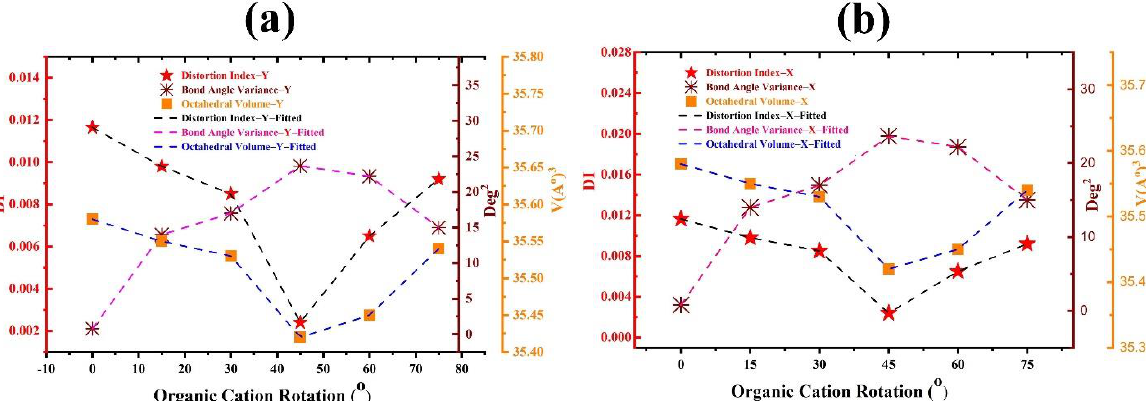
Figure 5. Calculated average distortion index (bond length), bond-angle variance, and average octahedra volume of FAPbBr 3 perovskite for different FA rotations: ( a ) in Y mode and ( b ) in X mode.